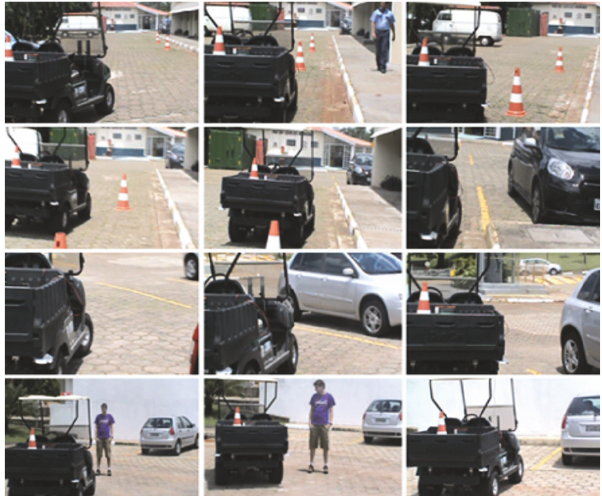
Figure 1: Images showing the vehicle moving towards goal while avoiding obstacles using SGBM (source